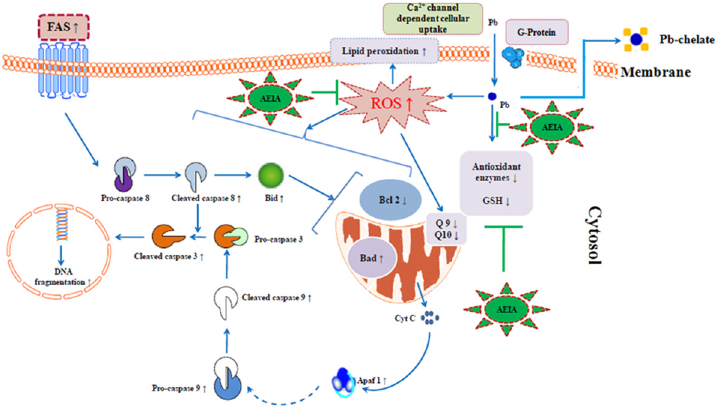
Fig 12. Schematic presentation of probable protective mechanism of AEIA against Pb toxicity. The blue arrows indicate the cellular events involved in Pb pathogenesis. The green colour line denotes the site of action of